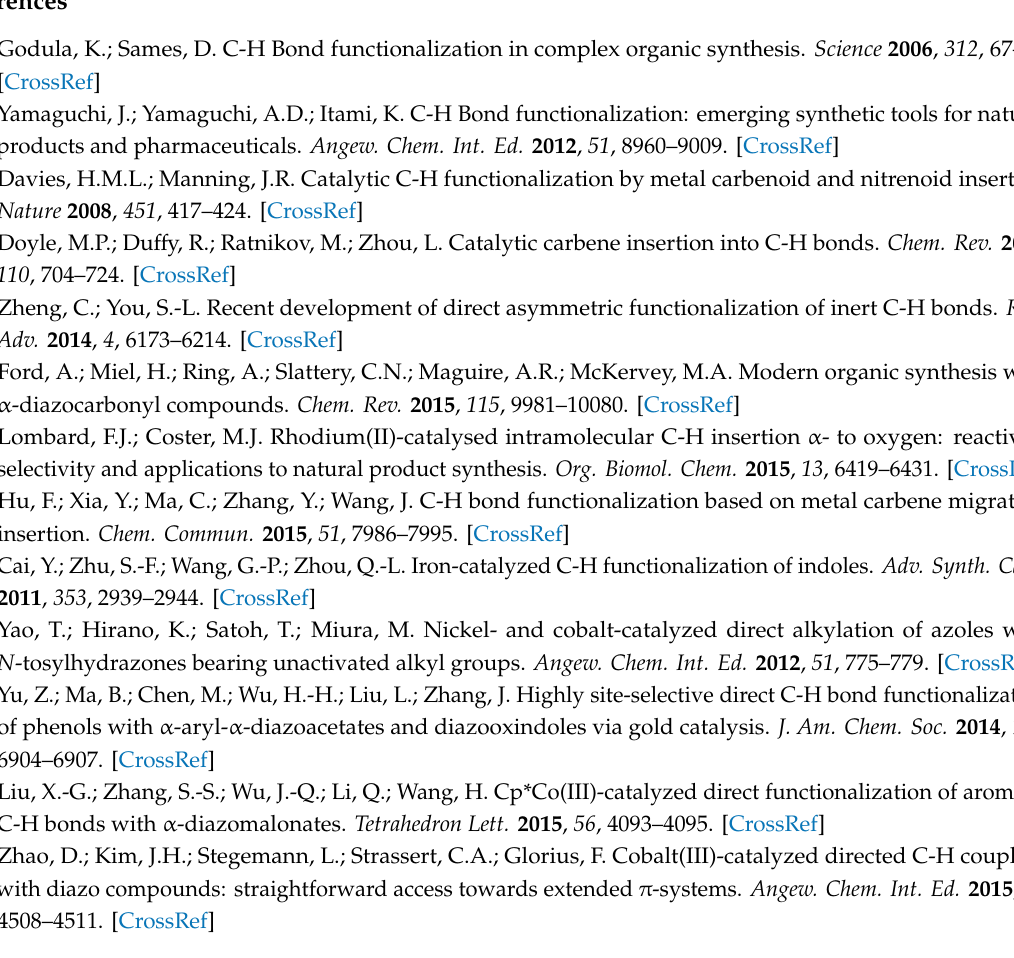
Supplementary Materials: The following are available online, Copies of 1 H and 13 C-NMR spectra of new compounds and Cartesian coordinates and total energies of all species described in the